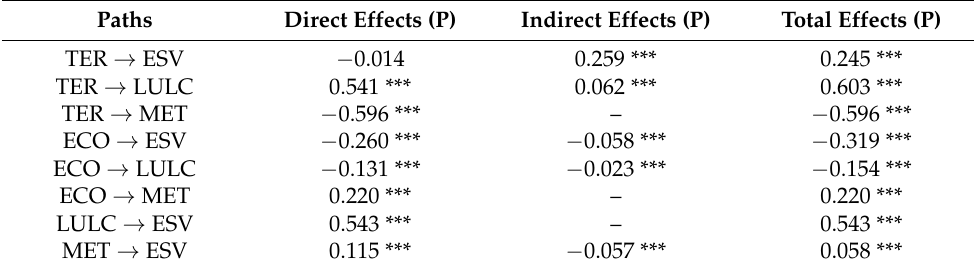
Figure 11. The structural equation model for the effects of different factors on ESV. *** indicates passing the 0.001 significance test. passing the 0.001 significance test. Table 8. Direct and indirect effects in the structural